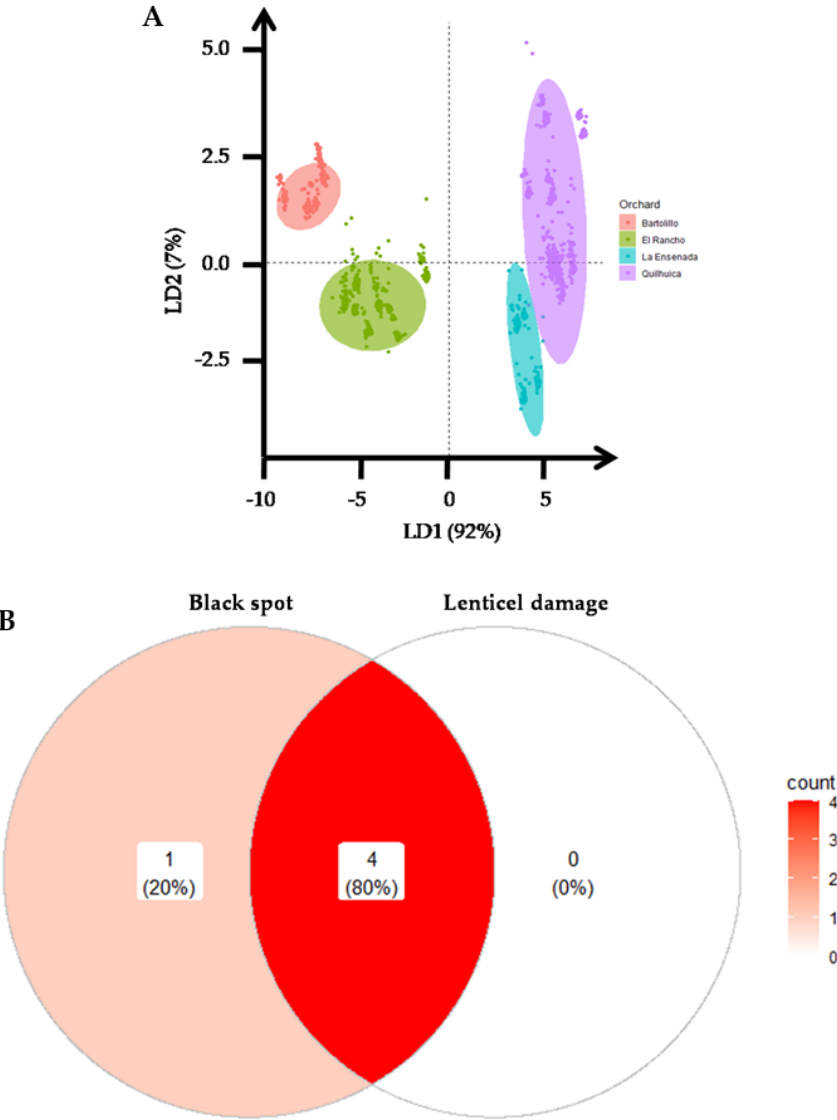
Figure 7. ( A ) Multivariate analysis, linear discriminant analysis (LDA). Red spot represents Bartolillo; green spot represents El Rancho; calypso spot represents La Ensenada; and purple spot represents Quilhuica. ( B ) Feature selection technique via information gain algorithm carried out for black spot and lenticel damage.